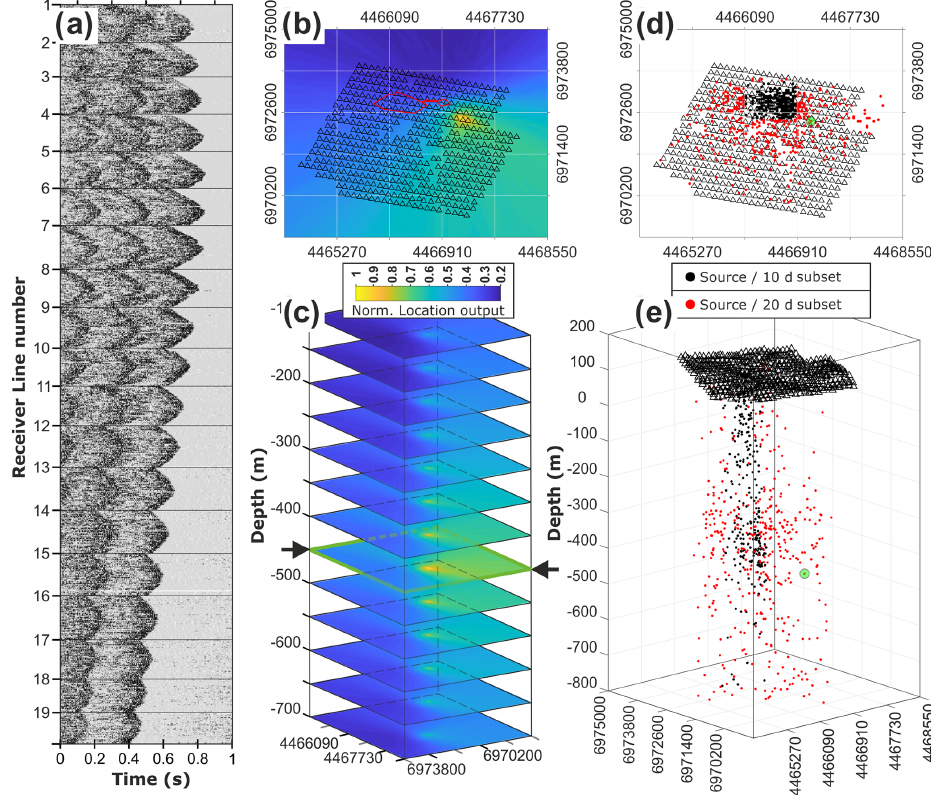
Figure 5. Performance of the combined TWEED and InterLoc processing scheme. (a) Scheduled mine event (underground blast) detected with TWEED, representing the typical body-wave event recorded by the Kylylahti array. Horizontal black lines mark the spatial extent of 19 receiver lines forming the complete Kylylahti array. (b) InterLoc output computed for the body-wave event shown in (a) using a 10s recording detected with TWEED. The color scale represents the normalized amplitude of the InterLoc output. Black triangles indicate geophone locations, and the red polygon corresponds to the mine location. (c) InterLoc output for a set of discrete depth intervals. Each result in (c) was normalized using the global maximum from all evaluated depth intervals. The x − y section at − 450m of depth exhibiting the clearest focus and highest amplitudes is highlighted with black arrows and represents the most probable depth of the event shown in (a) . (d) x − y and (e) 3D spatial distribution of the collection of sources at depth estimated during the 30 recording days projected on a map with the Kylylahti array (black triangles) and geographical coordinates. Dots represent the locations of the maximum InterLoc values of each detected body-wave event. The location of the event shown in (b) is denoted with a green circle. Black dots indicate the location of events, which were detected inside the subset of 10d, highlighted in Figs. 3 and 4 and used to evaluate the SI selective stacking performance. Red dots show the locations of events from the remaining